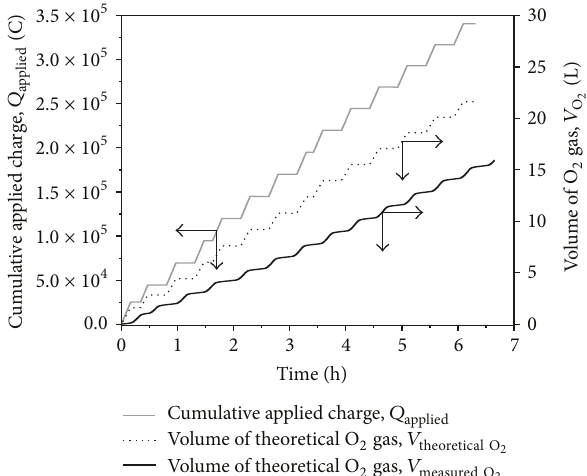
Figure 4: Comparison between the measured volume of O 2 gas ( 𝑉 measured O ) and theoretically calculated volume of O 2 gas 2 ( 𝑉 thoretical O ) generated by the cumulative applied charge, 𝑄 applied 2